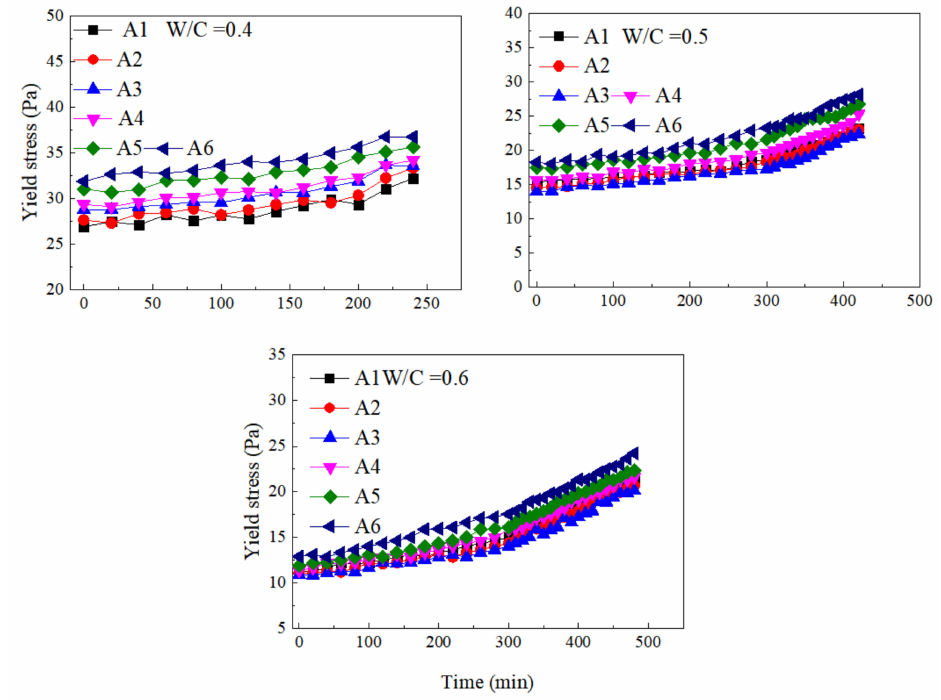
Figure 6. Variations of yield stress at different w/c ratios and SF substitute contents with time. Table 3. Yield stress-time equations of cement paste containing